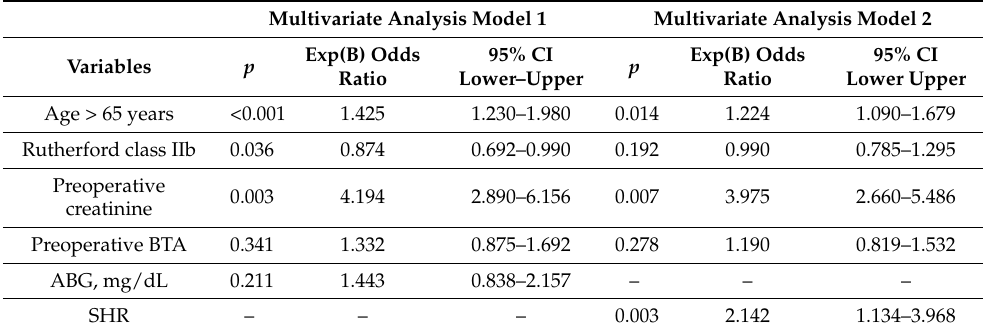
Table 4. Multivariate logistic regression analysis to show factors affecting the occurrence of postoper- ative acute kidney injury after surgical thromboembolectomy.